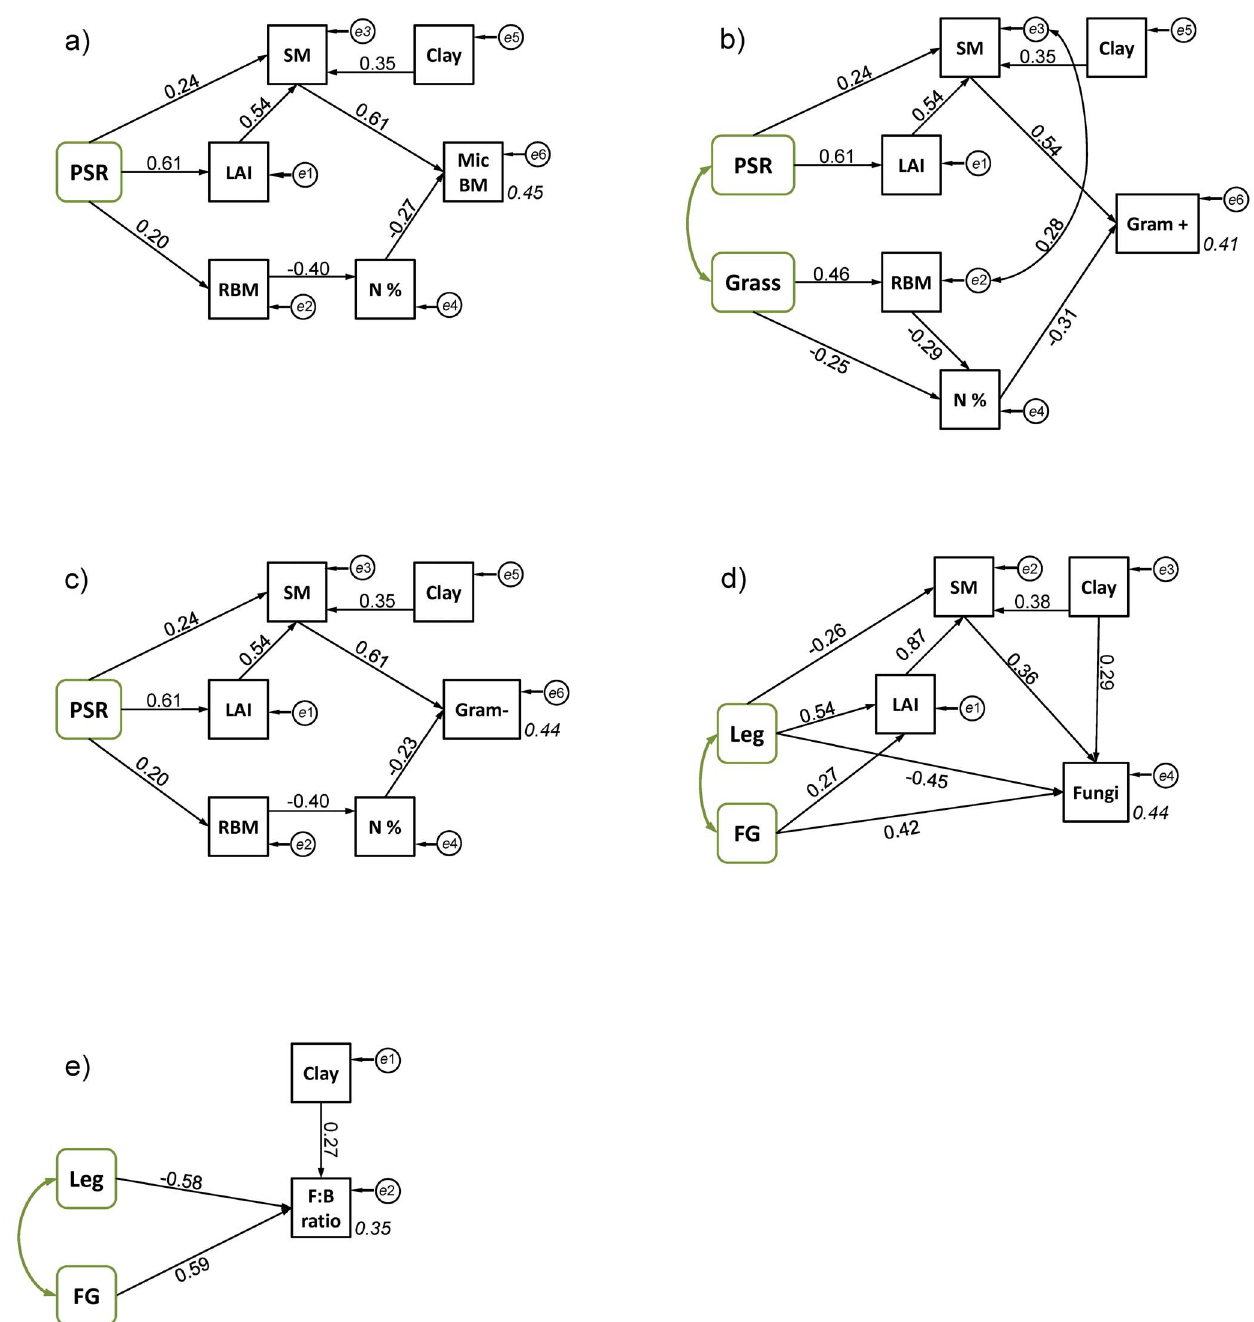
Figure 2. Minimal parsimonious models, testing direct and indirect effects of plant diversity on soil microbial community. Minimal SEM for a) total soil microbial biomass (MicBM), b) biomass of Gram positive bacteria (Gram + ), c) biomass Gram negative bacteria (Gram 2 ), d) fungal biomass (Fungi), and e) fungal-to-bacterial biomass ratio (F:B ratio). Arrows show significant relationships between variables. Numbers next to arrows show standardized parameter estimates (i.e., standardized regression weights). Circles (e1–e6) indicate error terms, and double-headed arrows indicate significant correlations between the error terms. Squared multiple correlations ( R 2 ) for the dependent soil microbial biomass are given next to the box of the dependent variable. See the non-standardized estimates of the regression weights in Table S3a-e. Abbreviations are PSR: plant species richness, FG: plant functional group richness, LEG: presence of legumes, GRASS: presence of grasses, RBM: fine root standing biomass, N%: nitrogen concentration of fine roots, LAI: leaf area index, SM: soil moisture, Clay: clay content of soil doi:10.1371/journal.pone.0096182.g002 from low plant richness plots to medium ones with eight plant both, fungal and bacterial biomass revealed that the F:B ratio was species, and decreased again in plots with high plant richness. more related to fungi (R 2 = 0.67, P , 0.001) than to bacterial biomass (R 2 = 0.043, P , 0.066). Regression analyses of the relationship between F:B ratio and